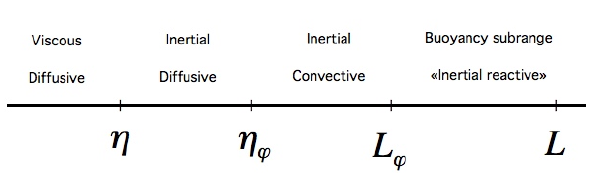
Fig. 10. Different regimes for an active tracer: here an “inertial reactive” regime if found for scales L φ ≤ ‘ ≤ L